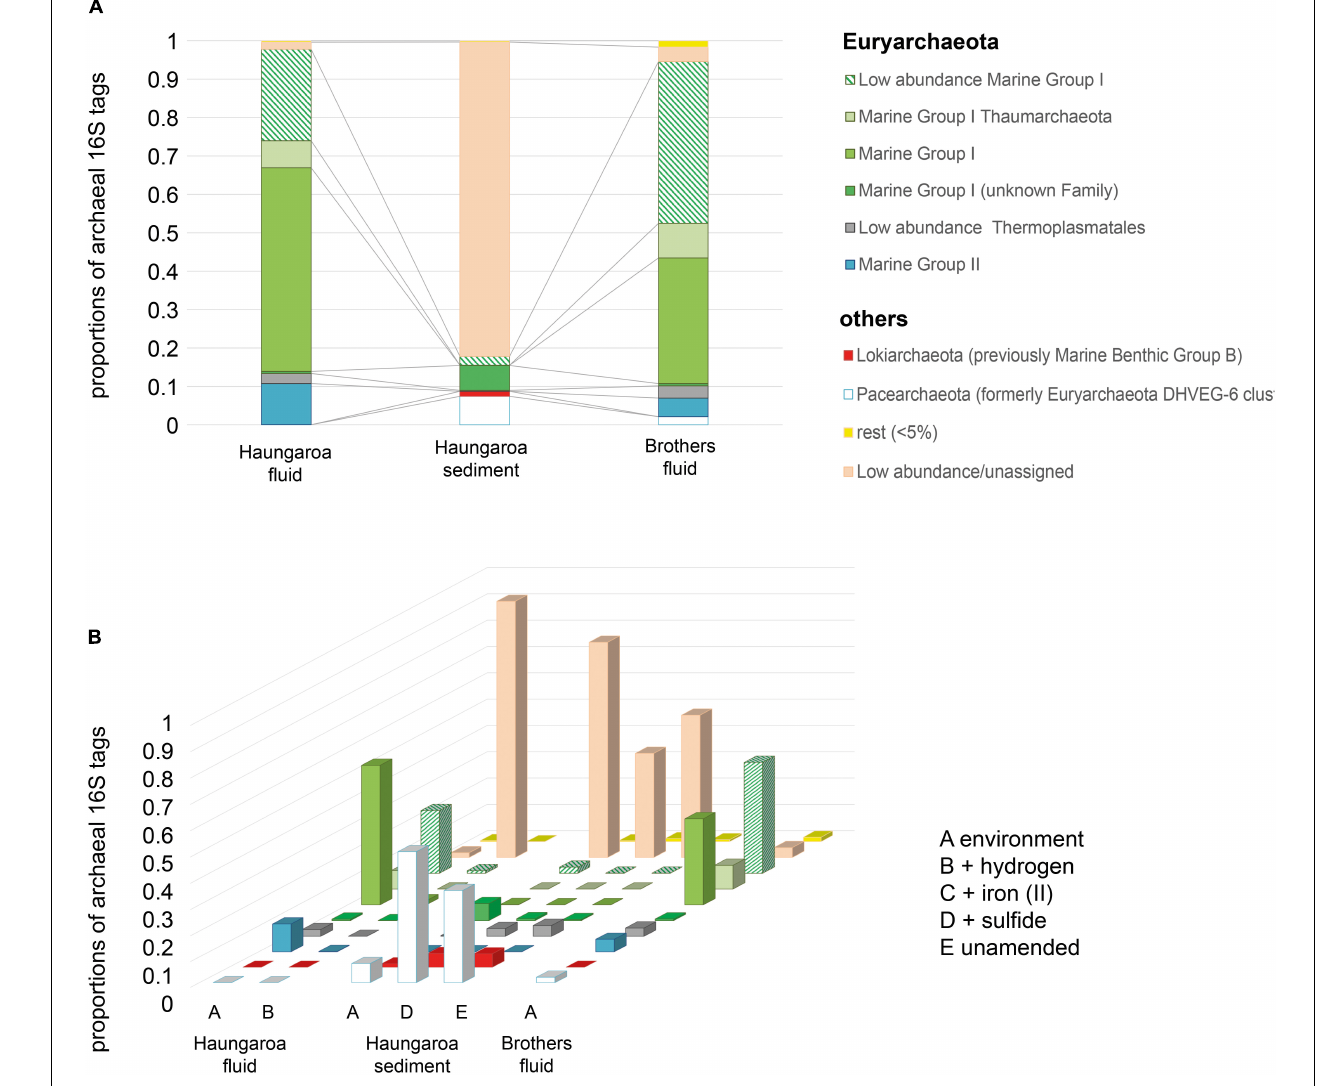
FIGURE 4 | Archaeal 16S rRNA tags with (A) DNA extracted from the environment, i.e., Haungaroa fluids (30 ROV 4F) and sediment sample (35 ROV 15M) and from the Brothers fluid sample (61 ROV 13F-15F) and (B) RNA isolated from incubation experiments with sediment and fluid